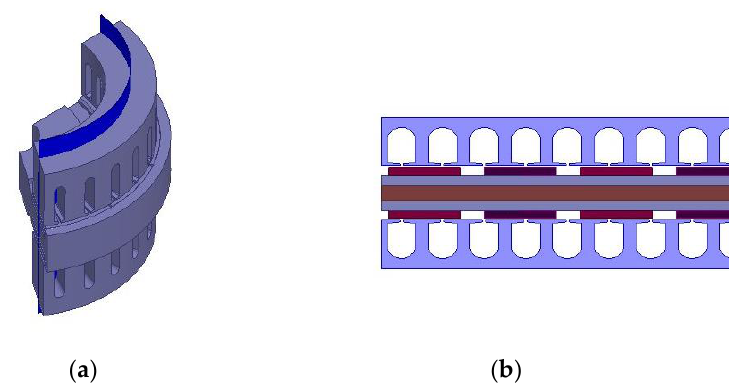
Figure 2. Double stator-single rotor type AFPMSM. ( a ) AFPMSM 3D model. ( b ) Equivalent linear motor model.